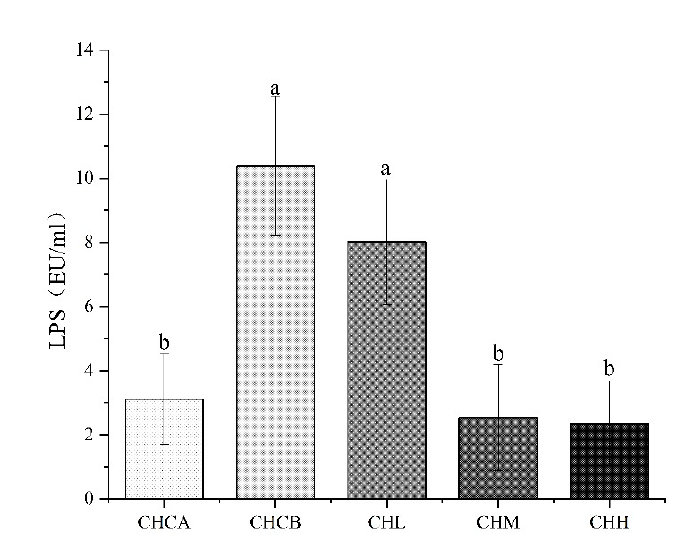
Figure 2. Effects of Water extract of CIF on serum LPS level. Values indicate mean ± SEM (n = 5). a, b. Values not sharing a common letter are significantly different among the groups ( p ≤ 0.05).